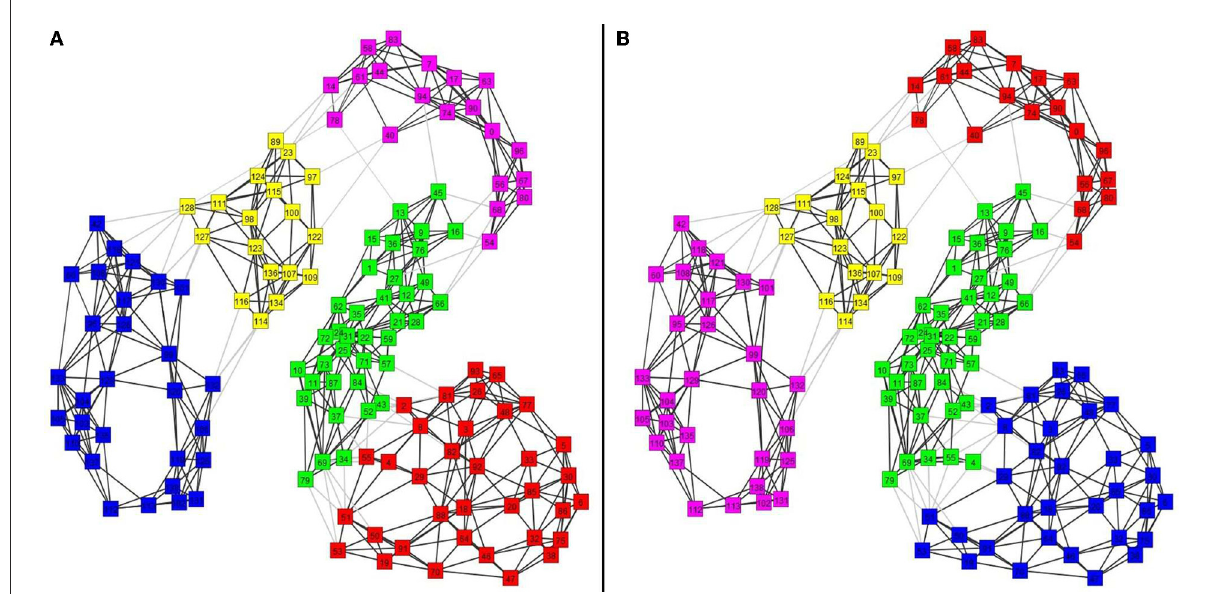
FIGURE11 Five clusters identified from the Shi and Malik algorithm (A) (modularity = 0.70 and conductance = 0.11) and Walktrap algorithm (B) (modularity = 0.70 and conductance =